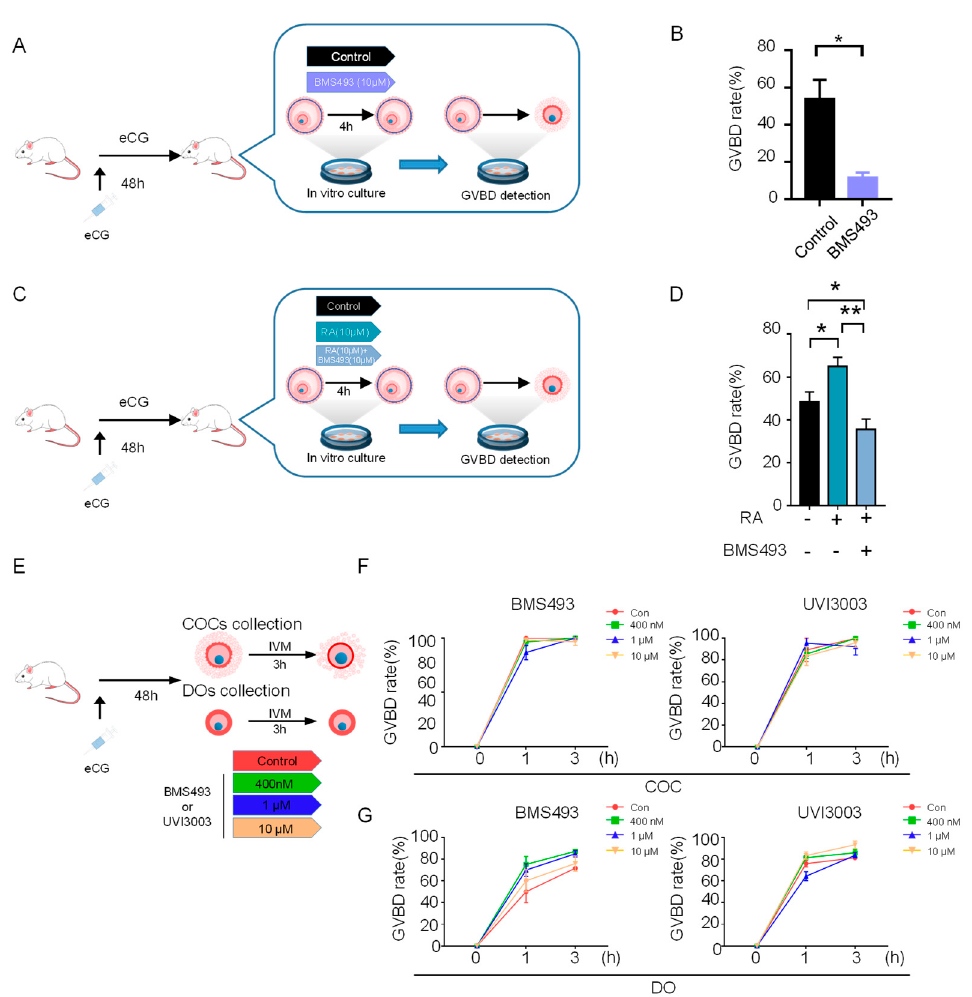
Figure 3. RA signaling disruption impairs oocyte meiotic resumption. ( A ) Flow chart of experimental design based on in vitro culture of eCG-primed preovulatory follicles treated with or without RAR pan-inhibitor BMS493. ( B ) Quantitative analysis of GVBD rates of oocytes collected from preovulatory follicles cultured under different IVM conditions. * p < 0.05 ( C ) Flow chart of experimental design based on in vitro culture of eCG-primed preovulatory follicles treated with RA alone or together with BMS493. ( D ) Quantitative analysis of GVBD rates of oocytes collected from preovulatory follicles cultured under different IVM conditions. * p < 0.05, ** p < 0.01. ( E ) Flow chart of experimental design based on IVM of COCs and DOs groups with or without different concentrations of BMS493 and UVI3003. ( F , G ) Quantitative analysis of GVBD rates of oocytes collected from COCs ( F ) and DOs ( G ) cultured with BMS493 or UVI3003. All data are presented as the mean ± SEM of three independent experiments. * p <